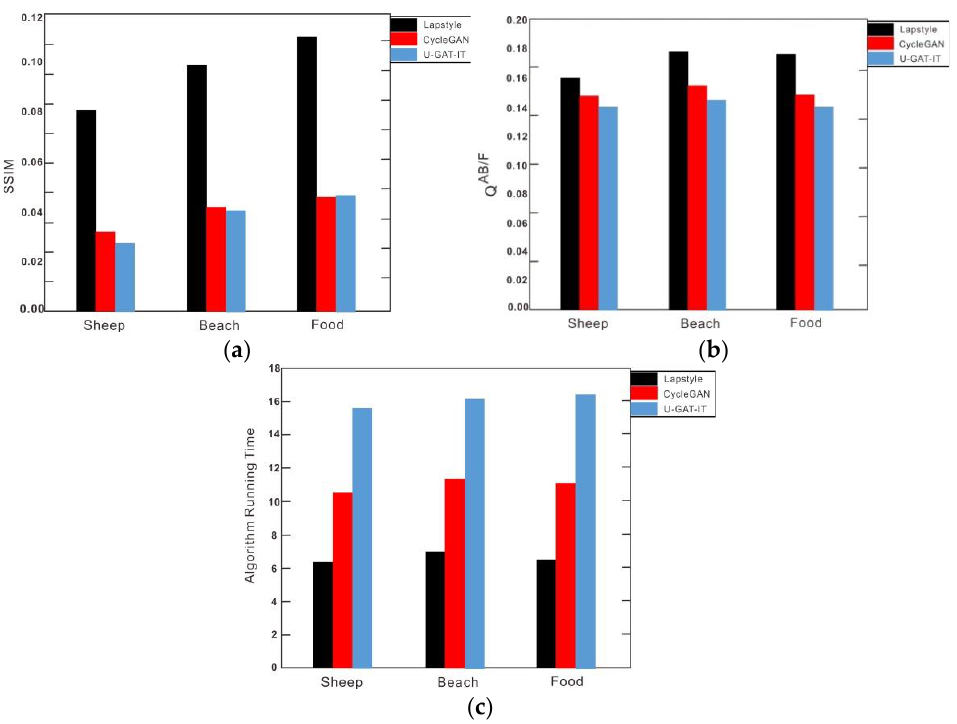
Figure 14. Evaluations of statistical indicators. ( a ) Taking the sheep, beach and food images as examples, the SSIM evaluated the quality of stylized images: the higher the SSIM index, the better the quality of the stylized image. The SSIM index of Lapstyle was significantly higher than for CycleGAN or U-GAT-IT. ( b ) Taking the sheep, beach and food images as examples, Q AB/F was used to evaluate the quality of stylized images: the higher the Q AB/F index, the better the quality of the stylized images. Lapstyle’s Q AB/F index was slightly higher than that of CycleGAN or U-GAT-IT. ( c ) Taking the sheep, beach and food images as examples, the running time of the algorithm was used to evaluate the efficiency of the migration method. Lapstyle generated the style migration effect map with the fastest speed and in the shortest time.